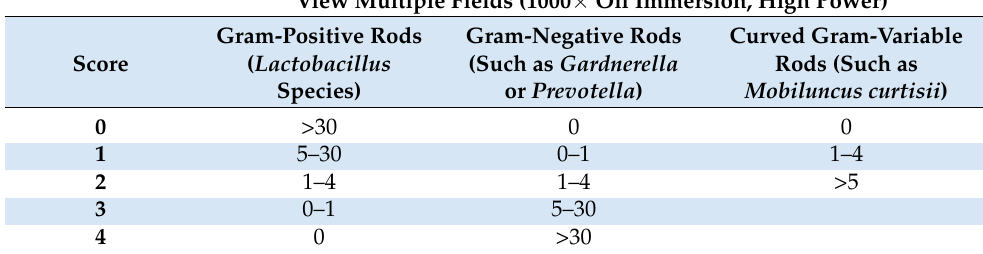
Table 2. Nugent scoring of the Gram stain. View Multiple Fields (1000 × Oil Immersion, High Power) Gram-Positive Rods ( Score